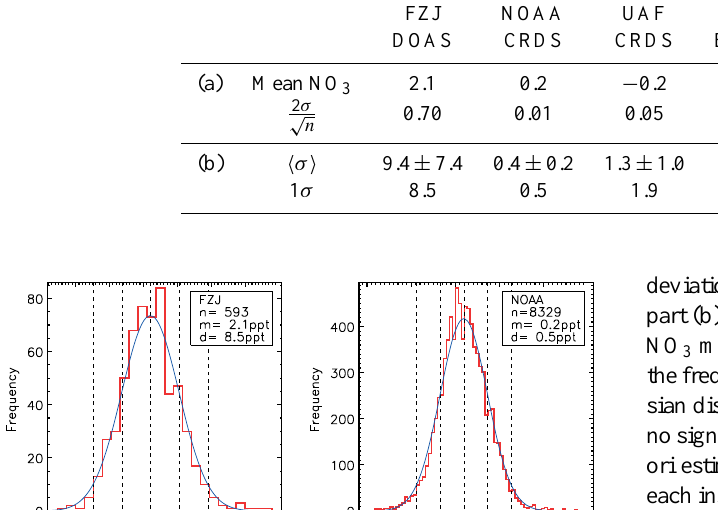
Table 2. (a) Mean NO 3 mixing ratio (centre of the frequency distribution, Fig. 2) and the corresponding confidence interval, 2 σ √ Comparison of the mean of the errors of zero-NO 3 measurements ( h σ i ) with the precision calculated from the frequency distribution of zero data (1 σ width of the Gaussian distribution). All values are in pptv.